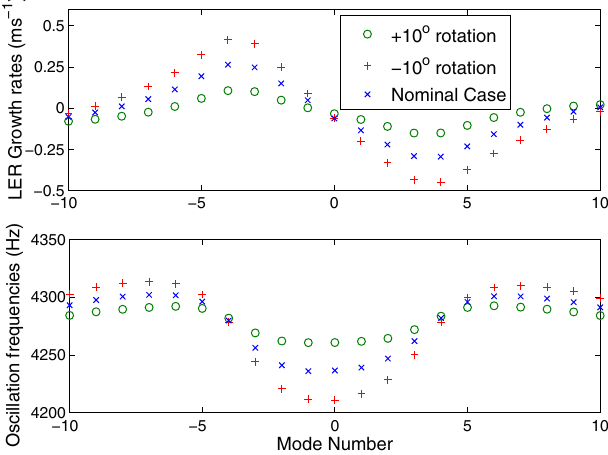
FIG. 11. (Color) Comb loop phase: (cid:2) 10 (cid:12) rotation in green, (cid:1) 10 (cid:12) rotation in red, and the nominal case for reference in blue.